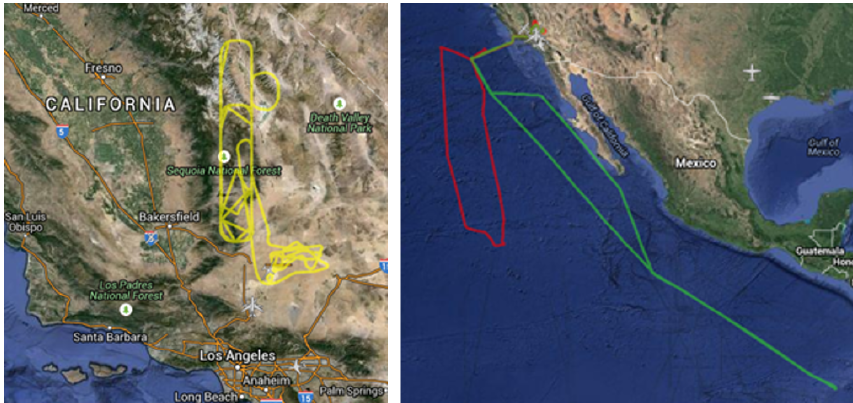
Figure 17. CAST-ATTREX Global Hawk flight paths in February and March 2015: 26 February 2015 in yellow (range flight), 5 March in green (science flight), and 10 March in red (science flight). Table 7. Summary of Global Hawk flights which took place under the CAST-ATTREX project during February and March 2015. Date (UTC) Take-off time, UTC (local) Duration